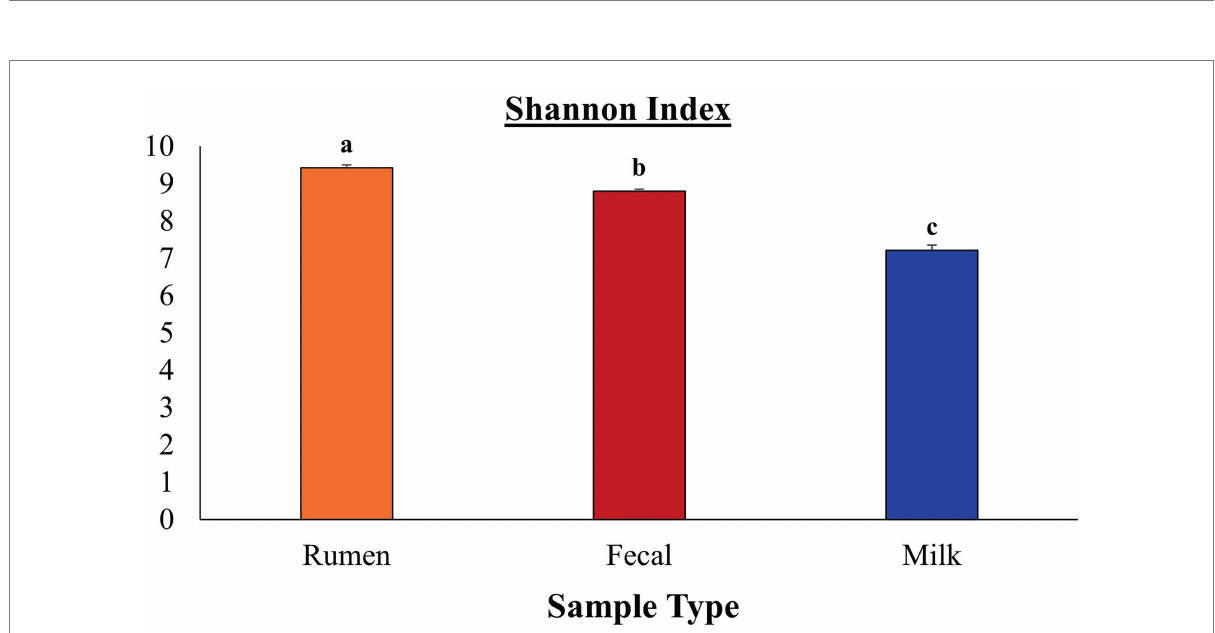
FIGURE 3 Comparison of Shannon diversity indices between rumen, fecal, and milk microbiota from Holstein dairy cattle. Sample types were significantly different ( p ≤ 0.05) according to Bonferroni’s multiple